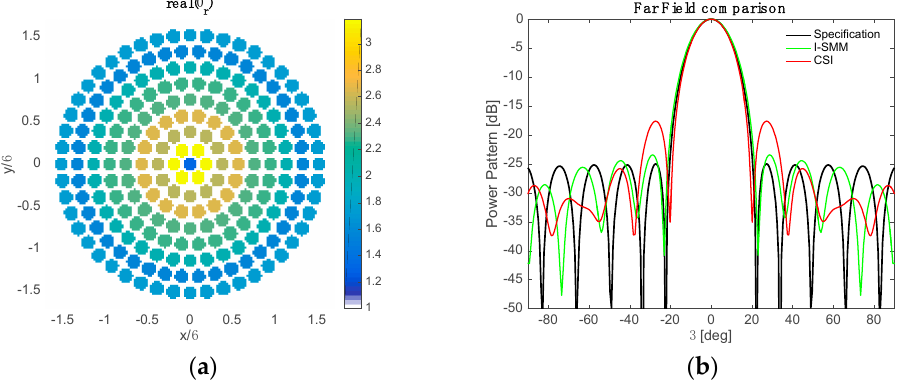
Figure 2. Synthesis of permittivity values for a GAM R -based lens with fixed radius [ τ = − 1.3697 + j0.4214]. ( a ) Real part of the permittivity function; ( b ) comparison on radiated far field.